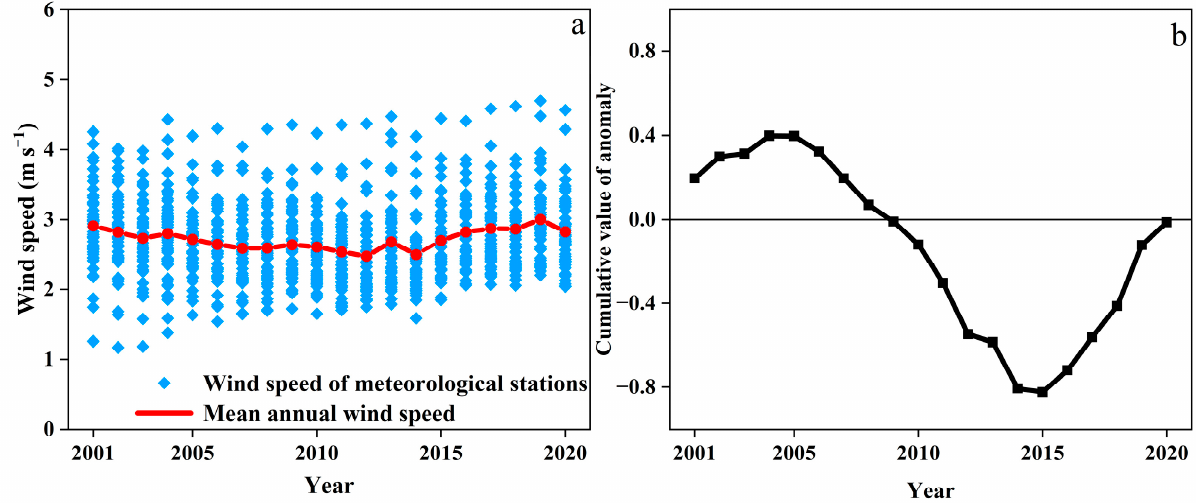
Figure 3. Interannual variation of the mean annual wind speed and its cumulative value of anomaly in water erosion area of the typical black soil region from 2001 to 2020. (( a ): mean annual wind speed, ( b ):cumulative anomalous values of mean annual wind speed).